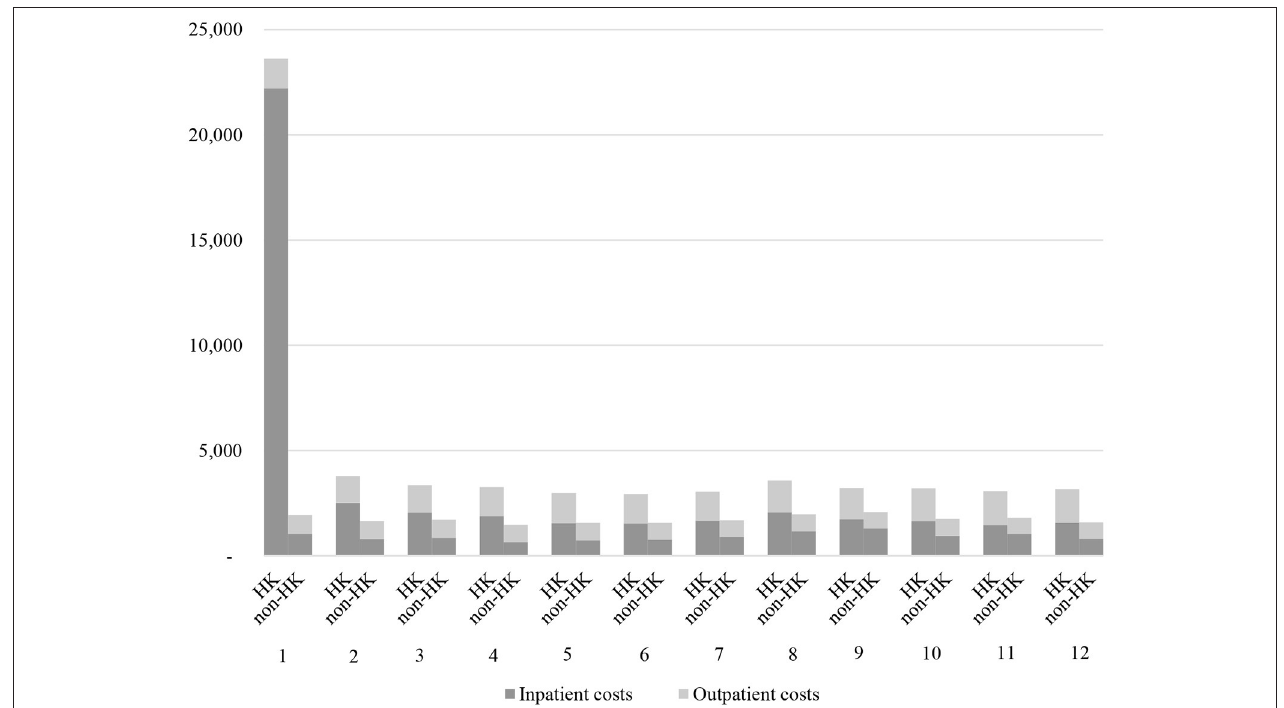
FIGURE 2 | The monthly all-cause direct medical costs in the 12-month follow-up period ( U ).